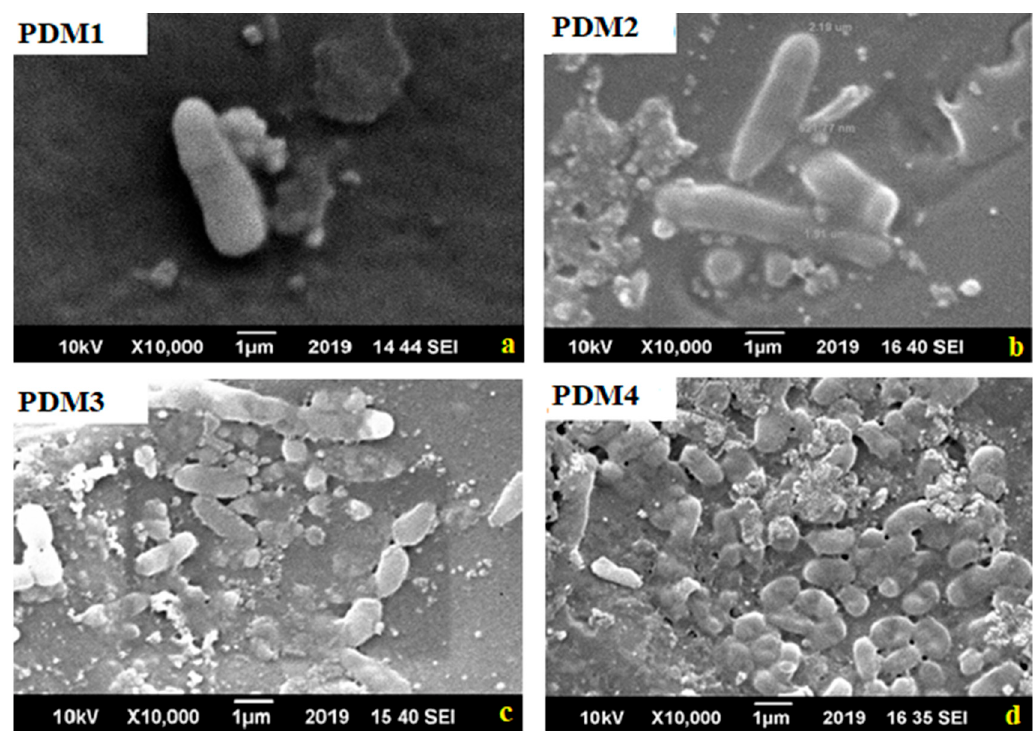
Figure 9. Scanning electron microscopy images for E. coli that shows biofilm formation trend in copolymers: ( a ) PDM1; ( b ) PDM2; ( c ) PDM3; ( d ) PDM4.